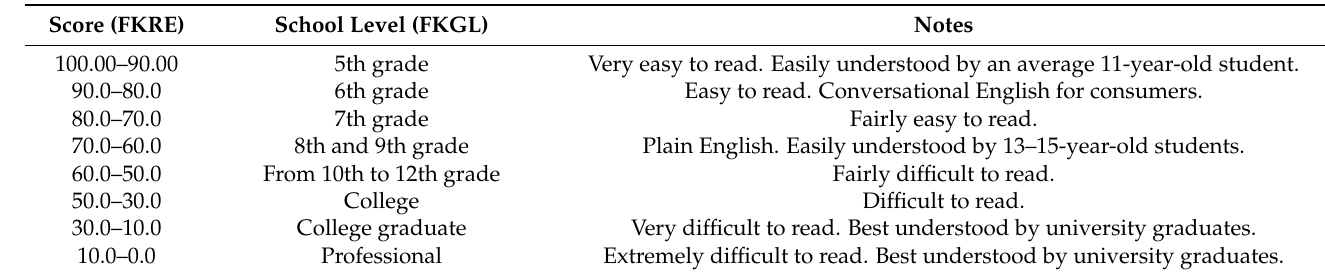
Table 1. Grading system and school levels (Flesch